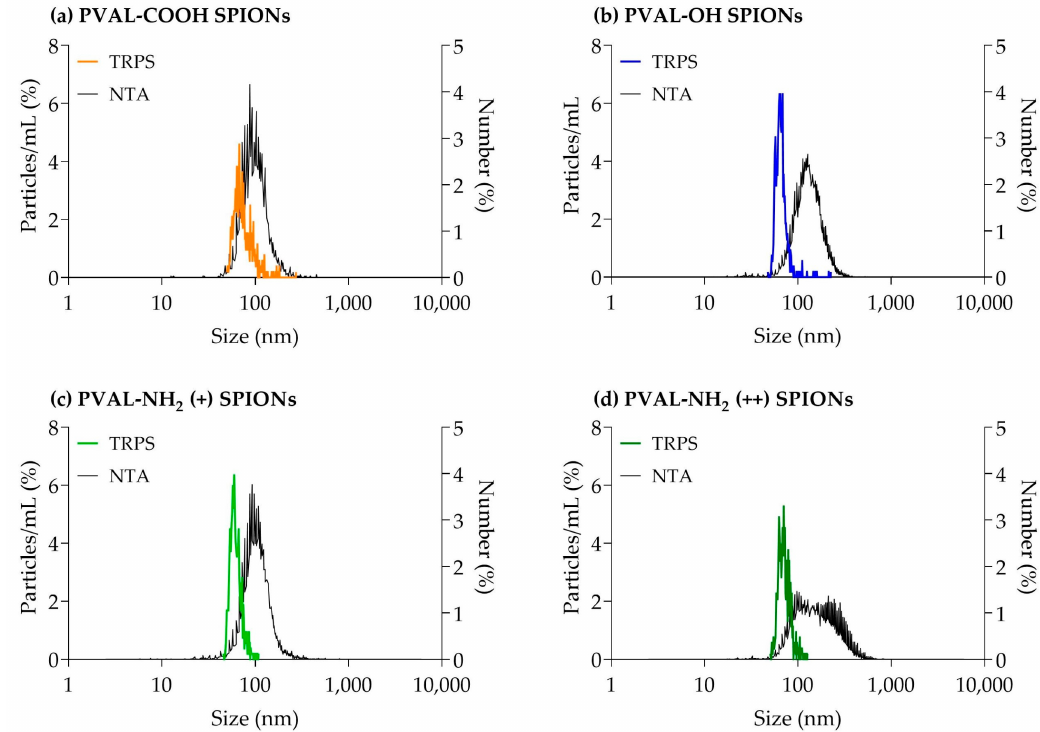
Figure 3. Graphs obtained from TRPS and NTA particle size measurements for ( a ) PVAL-COOH SPIONs, ( b ) PVAL-OH SPIONs, ( c ) PVAL-NH 2 SPIONs (+) and ( d ) PVAL-NH 2 SPIONs (++). TRPS size distribution was plotted as a percentage of the total particles/mL (left axis). The NTA size distribution was plotted as a percentage of the total number of measured NPs (right